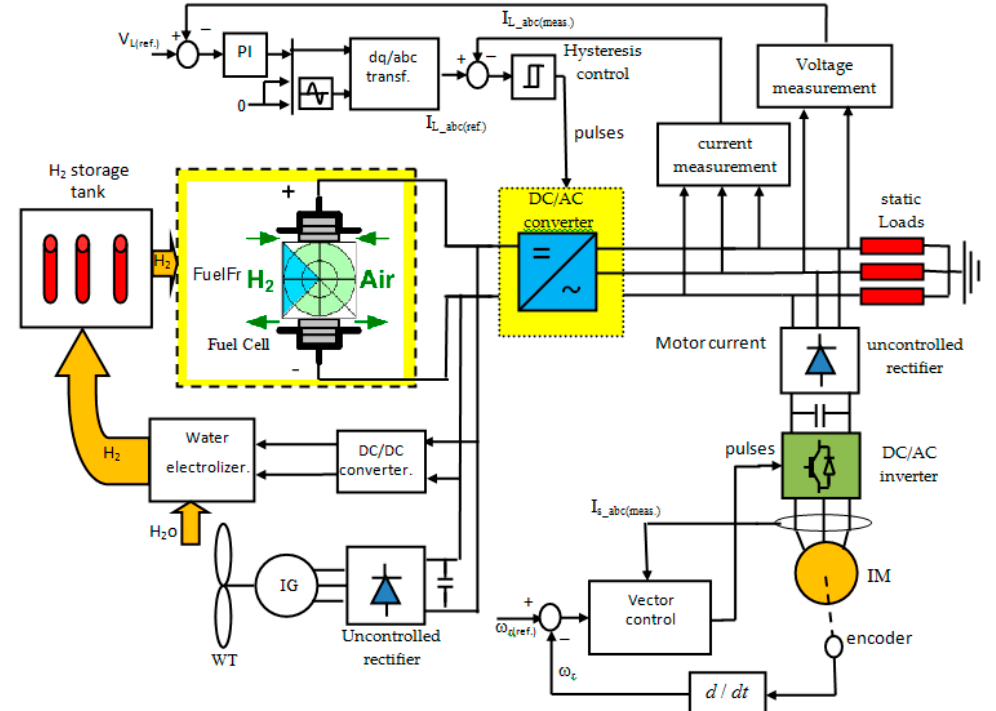
Figure 1. The proposed microgrid energy system and its controllers.